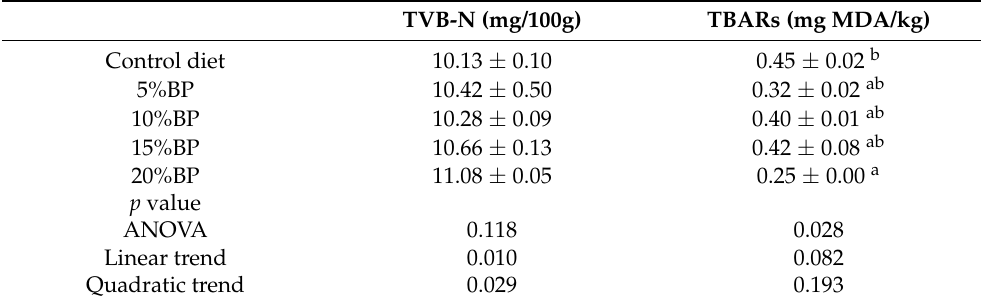
Table 6. The content of TVB-N and TBARs of muscle in grass carp fed a diet with paper mulberry (BP) for 8 weeks.